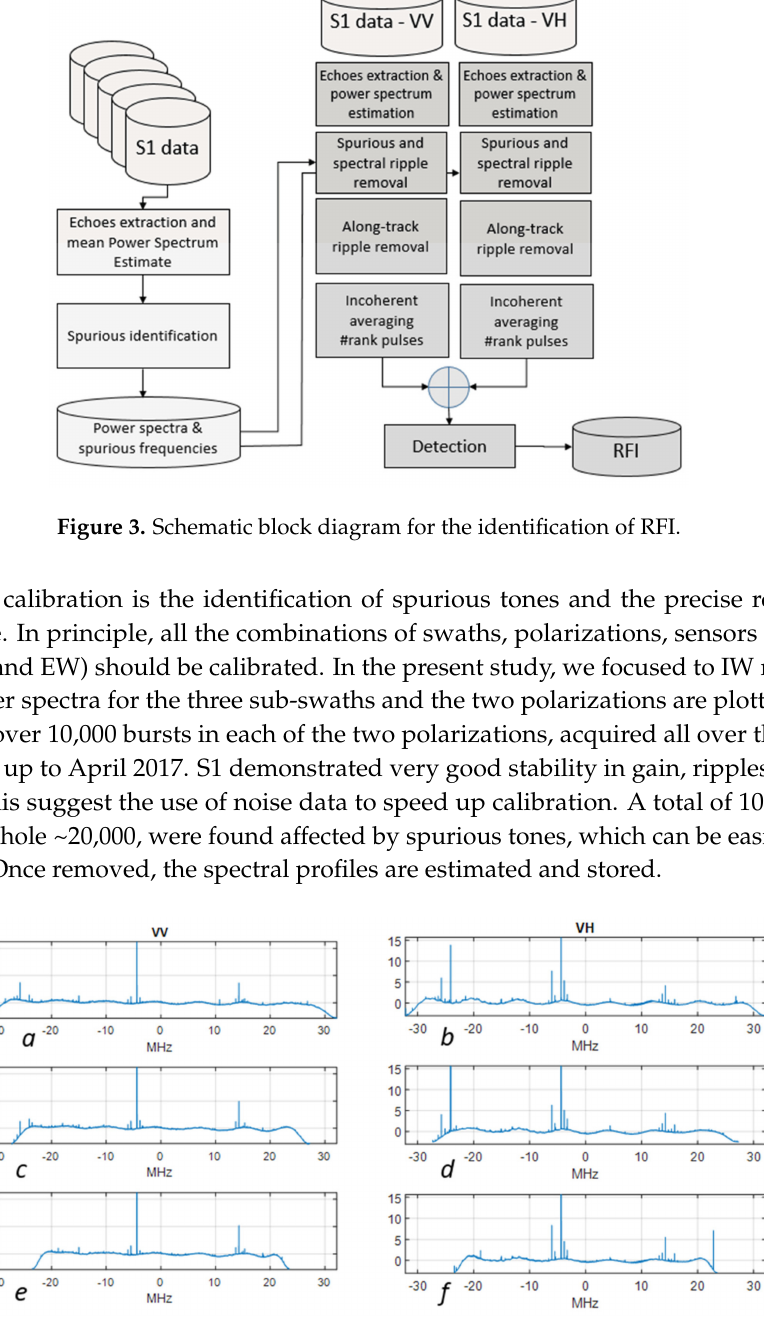
Figure 4. Mean power spectrum density, dB, measured from the “rank” pulses at beginning of each swaths in V ( a , c , e ) and H ( b , d , f ) polarizations, for sub-swaths IW1 ( a , b ), IW2 ( c , d ) and IW3 ( e , f ) , averaged on 10,000 bursts. Notice the spurious tones and the